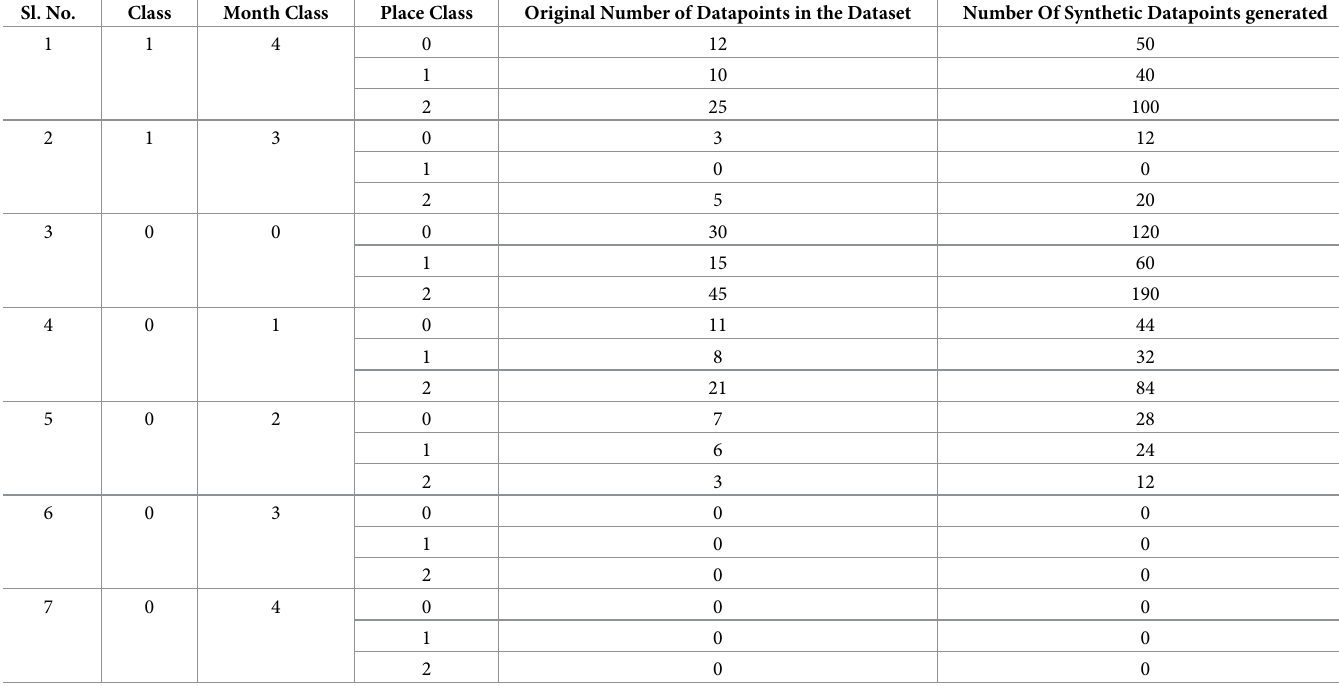
Table 3. Synthetic data generation using the MC technique where the mean and covariance matrices are not shared between the classes. Sl.